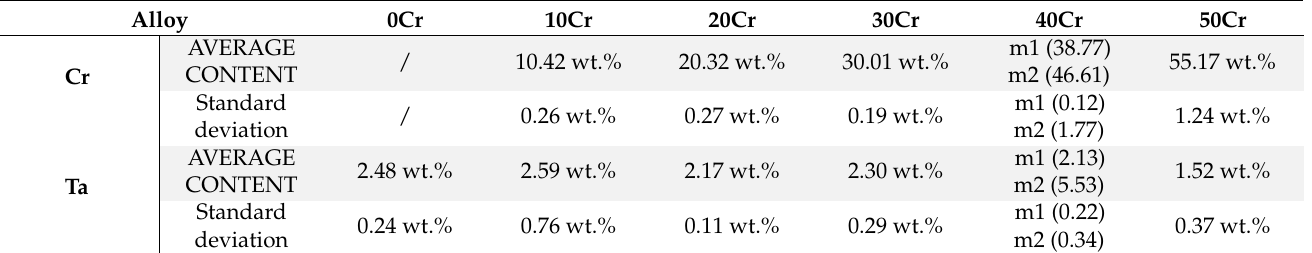
Table 3. Chemical compositions of the metallic phases present in the six alloys (all contents in